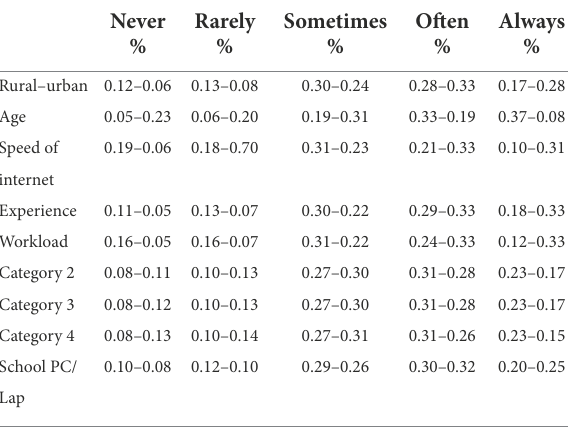
TABLE 6 Marginal predicted probabilities of model 3 (min-max/max- min change). Probability for each